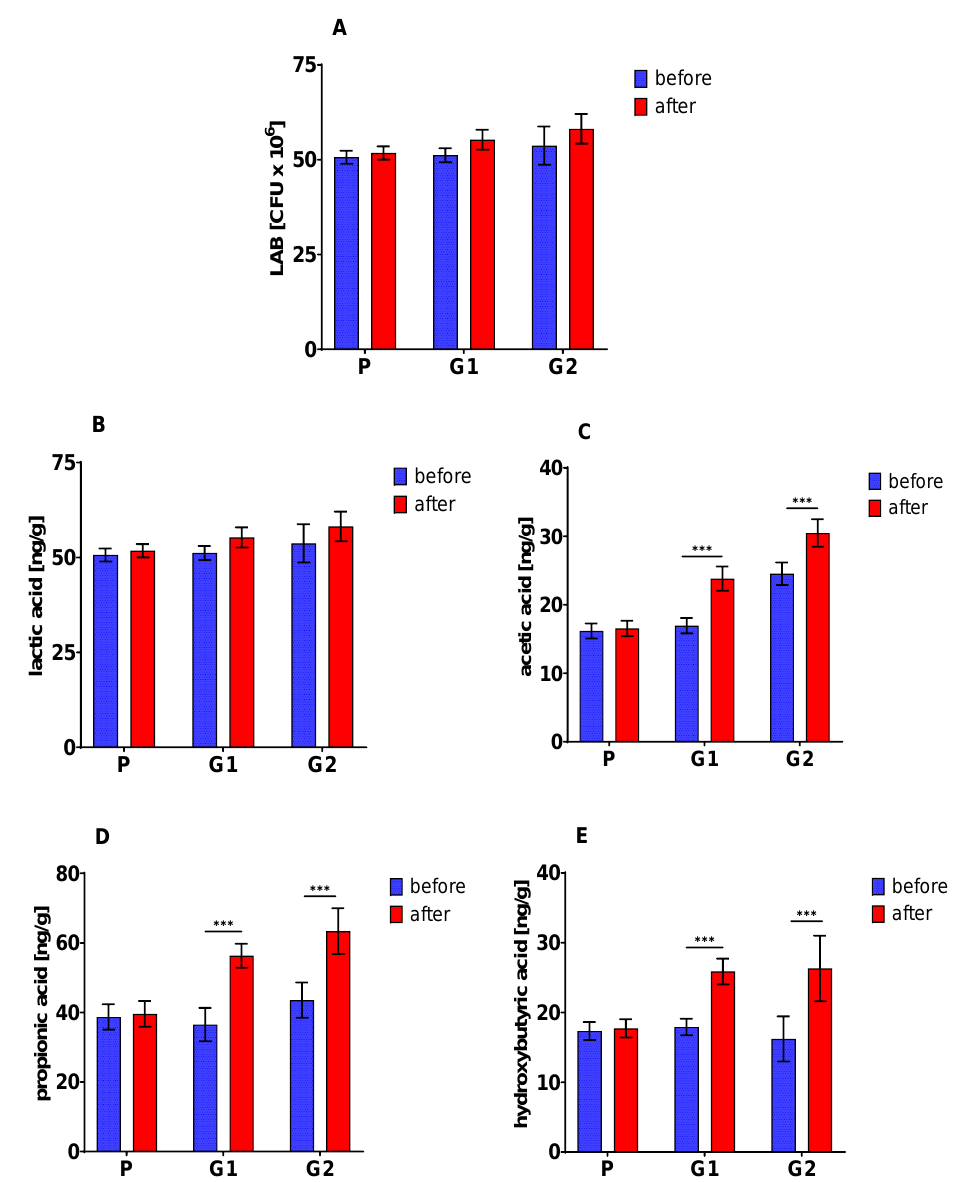
Figure 3. Lactic acid bacteria ( A ) and short-chain fatty acids (lactic, acetic, propionic and hydroxybutyric) ( B – E ) in feces. The asterisks (***) denote a statistically significant difference after vs. before dietary intervention, set at p < 0.001.